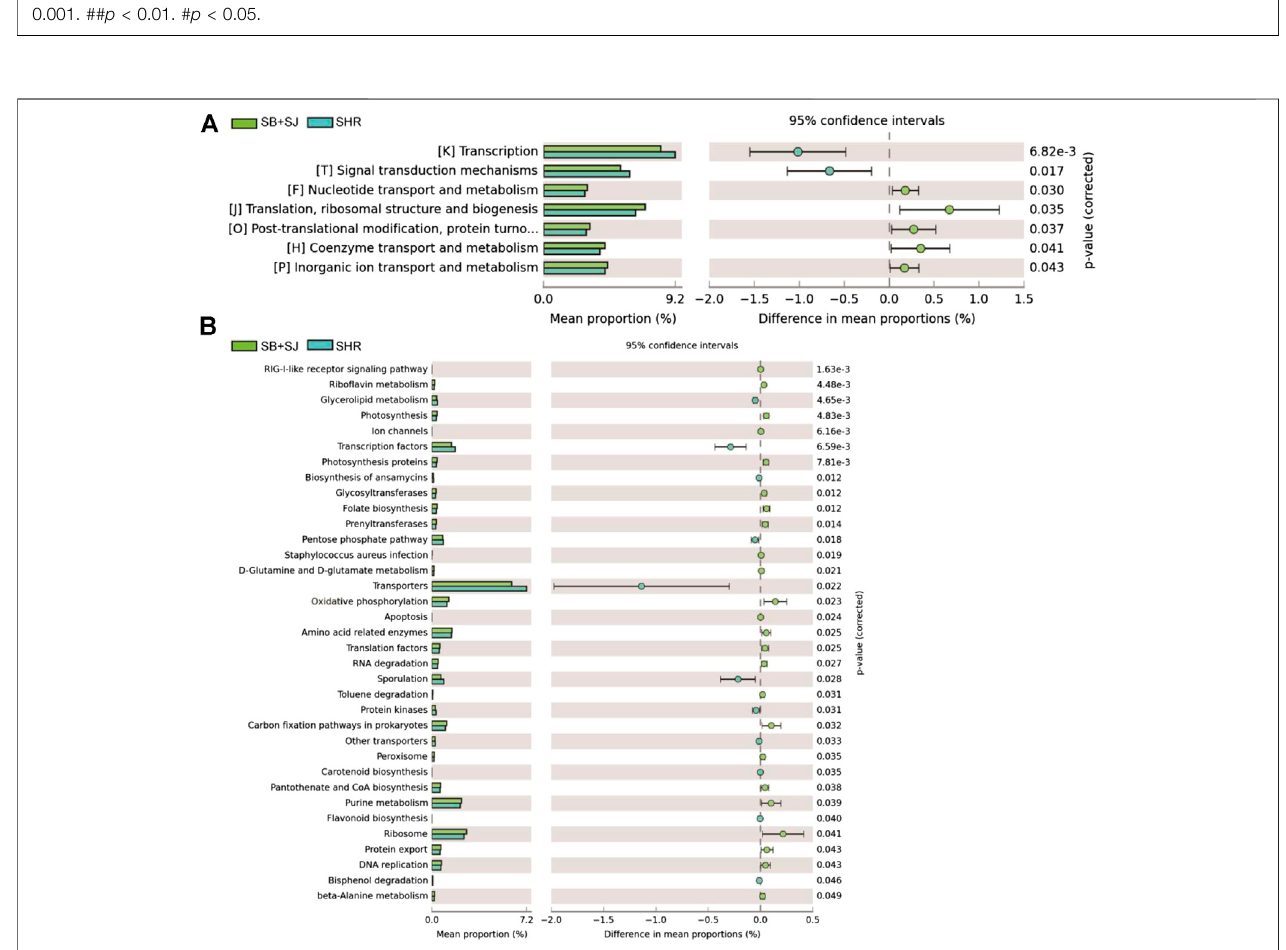
FIGURE9| PICRUStpredictionsofthefunctionalcompositionofgutmicrobiotabetweentheSB ＋ SJcombinationgroupandSHRgroup. (A) COGcategories. (B) KO categories.